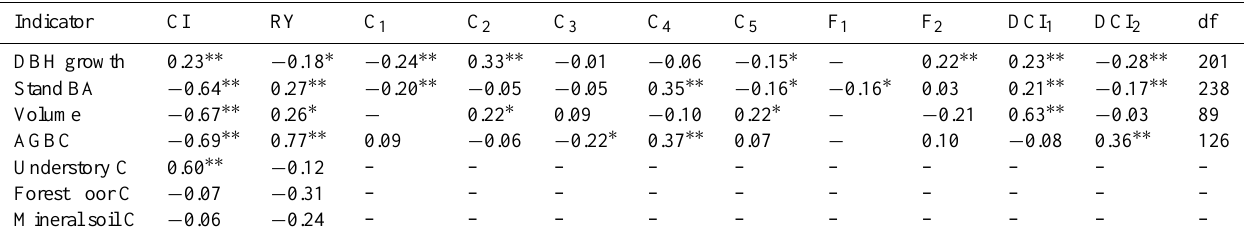
Table 2. Partial correlation coefficients between relative changes of the seven variables (related to forest structure and C storage) and potential driving